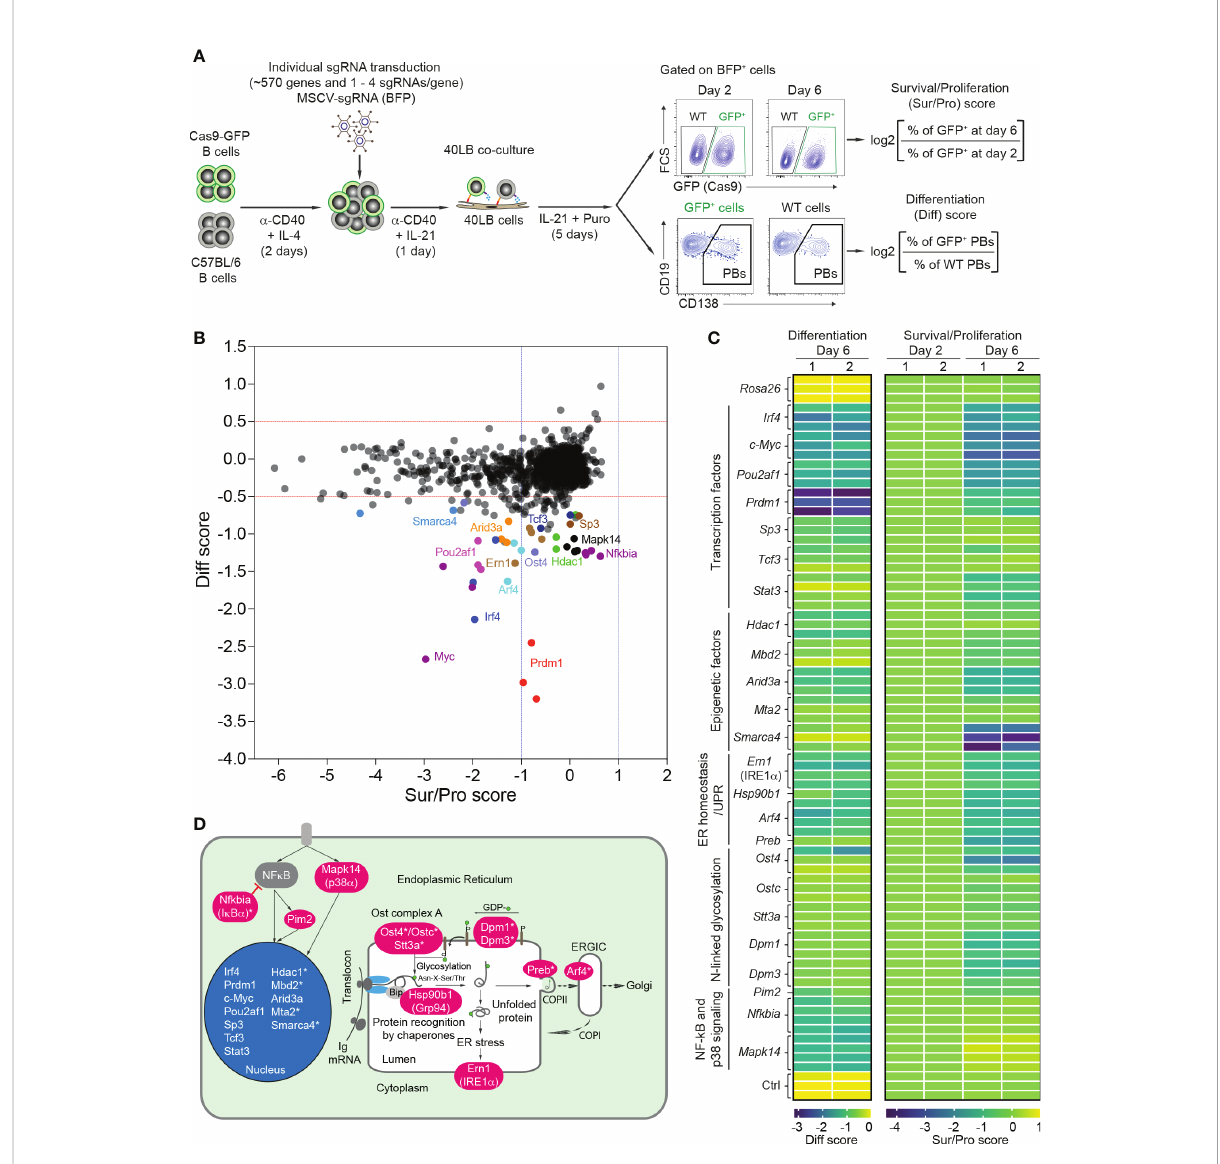
FIGURE 1 CRISPR/Cas9-mediated screen to differentiate B cell survival/proliferation and plasma cell differentiation. (A) Scheme of CRISPR/Cas9-mediated screen in 40LB culture system. Cas9-expressing B cells were isolated from R26-Cas9iGFP/+ mice, mixed with C57BL/6 (WT) B cells at a ratio of 50:50, and activated with a -CD40 antibodies and IL-4 for 2 days. The activated B cells were transduced with retroviral particles expressing speci fi c sgRNAs in 96 well plates. 1 day after transduction, the transduced cells were transferred into 96 well plates containing irradiated 40LB feeder cells and cultured in the presence of IL-21 and puromycin. These cells were analyzed at day 2 and 6 after transduction by fl ow cytometry. Pre-gating on BFP + (sgRNA) population, survival/proliferation (Sur/Pro) and differentiation (Diff) scores were de fi ned as log2 (fold change). (B) Representative correlation graph showing survival/proliferation vs differentiation scores from one of two experiments (n=2 biological replicates). The cutoffs of log2 fold change for differentiation (<-0.5) and survival/proliferation (<-1) scores are indicated with red and blue dashed lines, respectively. (C) Heatmaps showing differentiation (left) and survival/proliferation (right) scores for 24 genes affecting PB differentiation. (D) 24 genes affecting PB differentiation were mapped to cellular components. Asterisks indicate newly identi fi ed